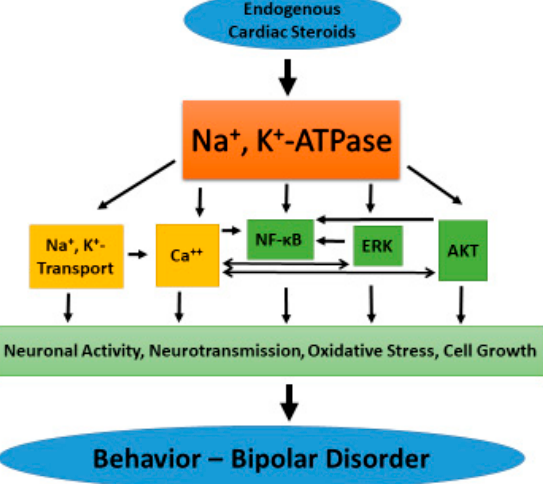
Figure 2. Schematic representation of the link between ECS, Na + , K + -ATPase and BD. See text for details.